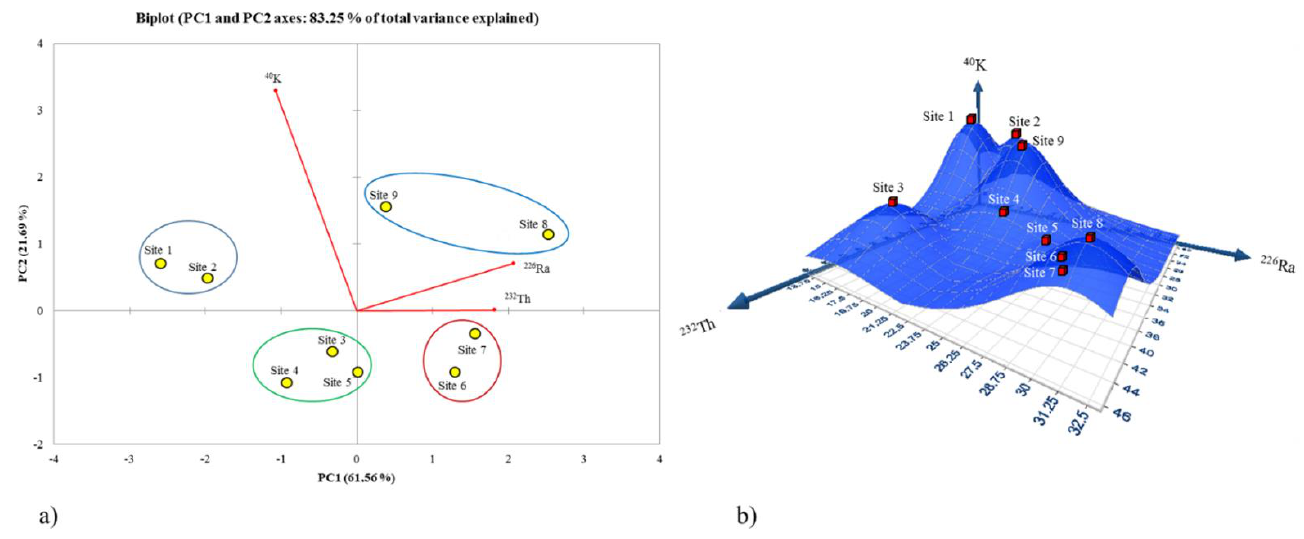
Figure 3. Two-dimensional (2D) plots of the first two Principal Components (PCs) obtained through Principal Component Analysis (PCA) elaboration starting from 40 K, 232 Th and 226 Ra activity concentrations ( a ). Mean concentration three-dimensional (3D) map of 40 K, 232 Th and 226 Ra into the investigated sites ( b ).